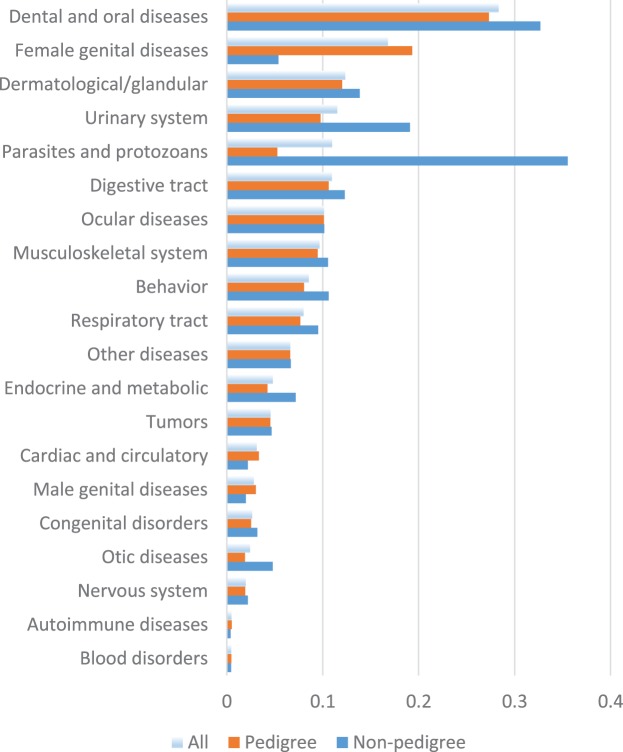
Bar chart of prevalence of disease categories among all cats, pedigree cats, and non-pedigree cats.